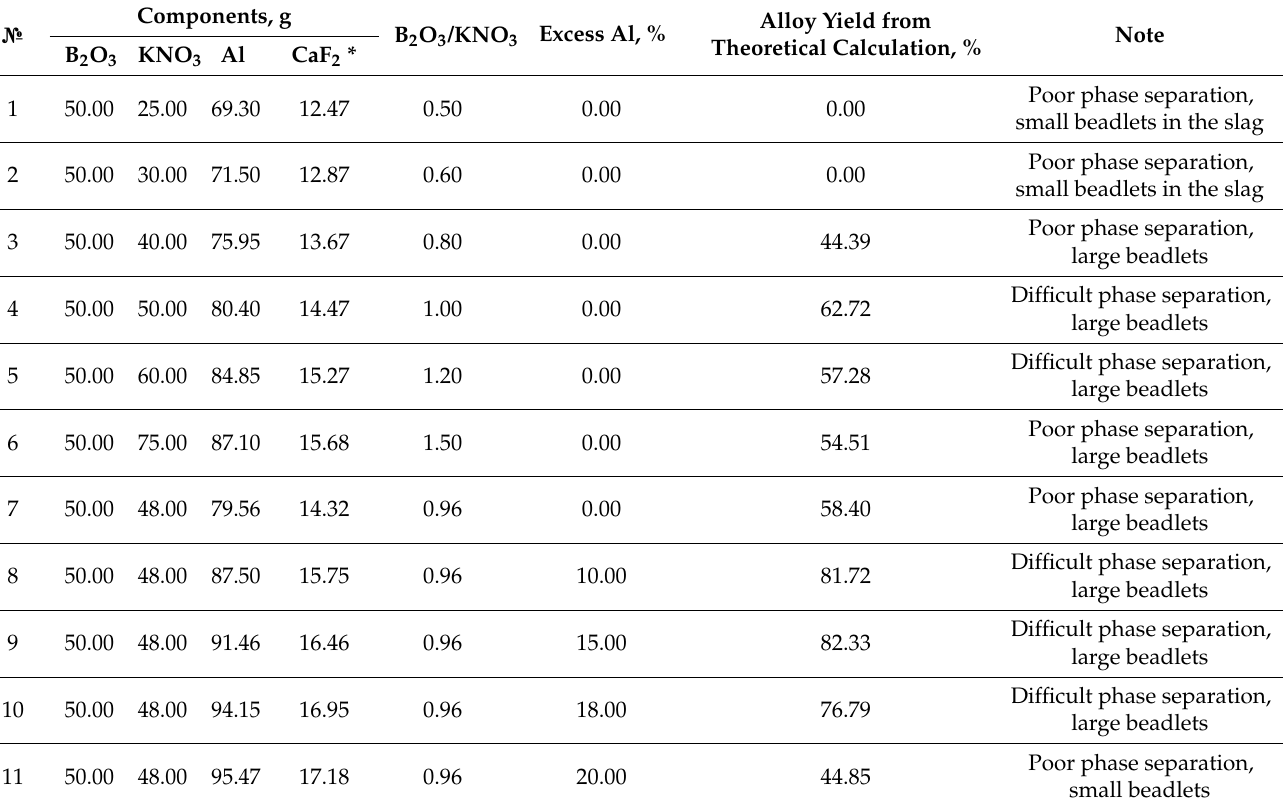
Table 2. Compositions and results of experiments on the effect of the ratio of the heating additive and boric anhydride, the amount of reducing agent on the yield of aluminum boride